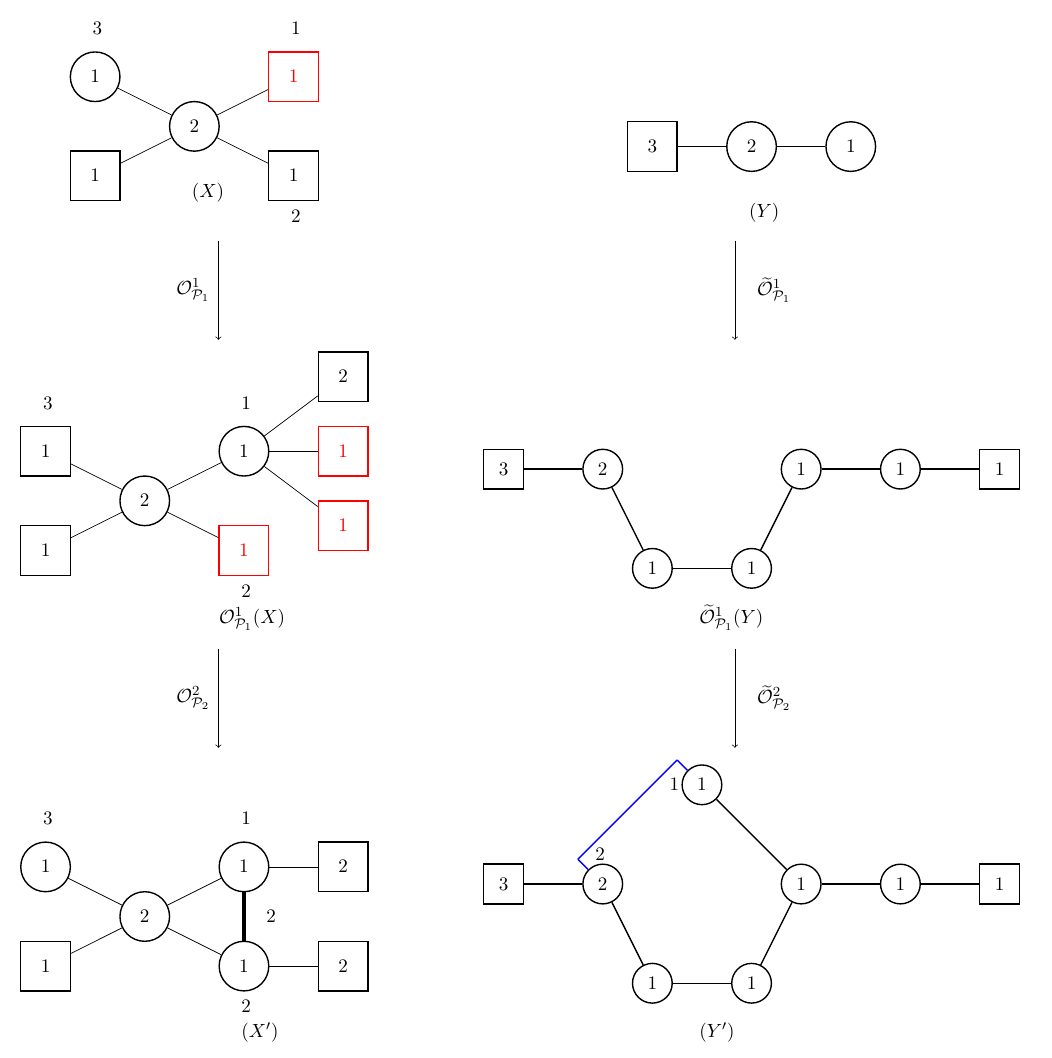
Figure 16 . The construction of the quiver gauge theory X 0 of figure 14 by a sequence of two elementary Abelian S -type operation. The labels i = 1 , 2 on the flavor nodes correspond to the mass parameters u . At each step, the flavor node on which the elementary operation acts is shown i in